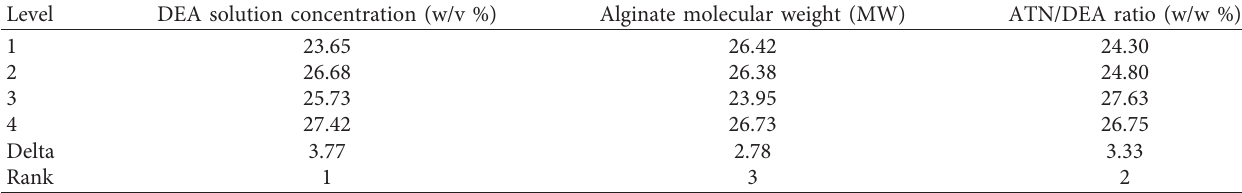
Figure 4: 3D trajectory plot analysis for particle size effects with the combination of factors: (a) DEA solution concentration and alginate molecular weight, (b) alginate molecular weight and ATN/DEA ratio, and (c) ATN/DEA ratio and DEA solution concentration. Table 6: Mean of zeta potential responses with respect to process parameters and their levels.